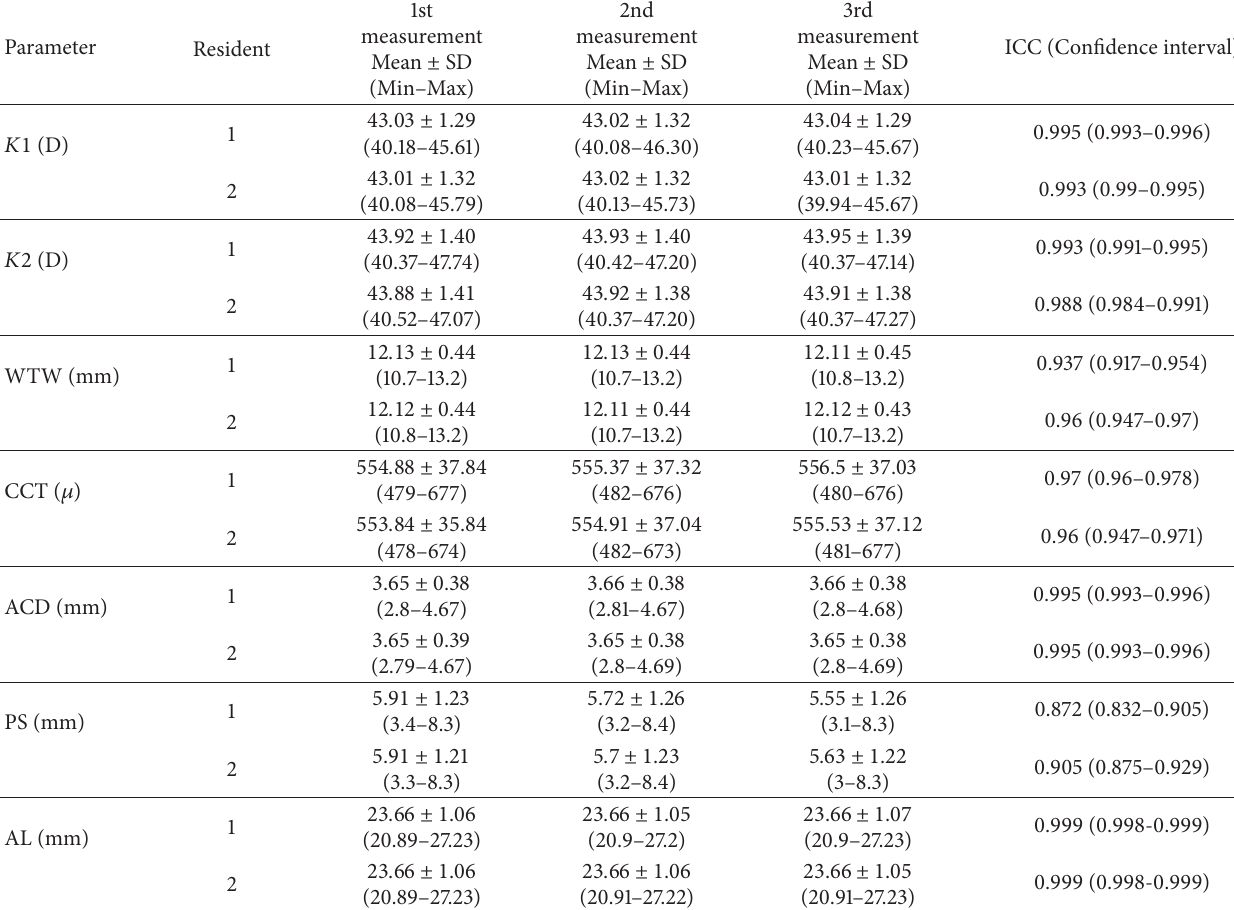
Table 1: Comparison of three consecutive biometric measurements taken by both ophthalmology residents